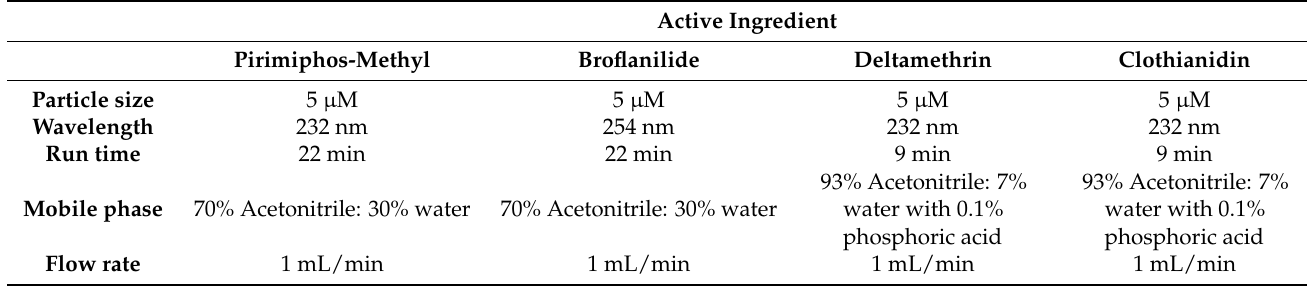
Table 1. HPLC methodology per active ingredient in the